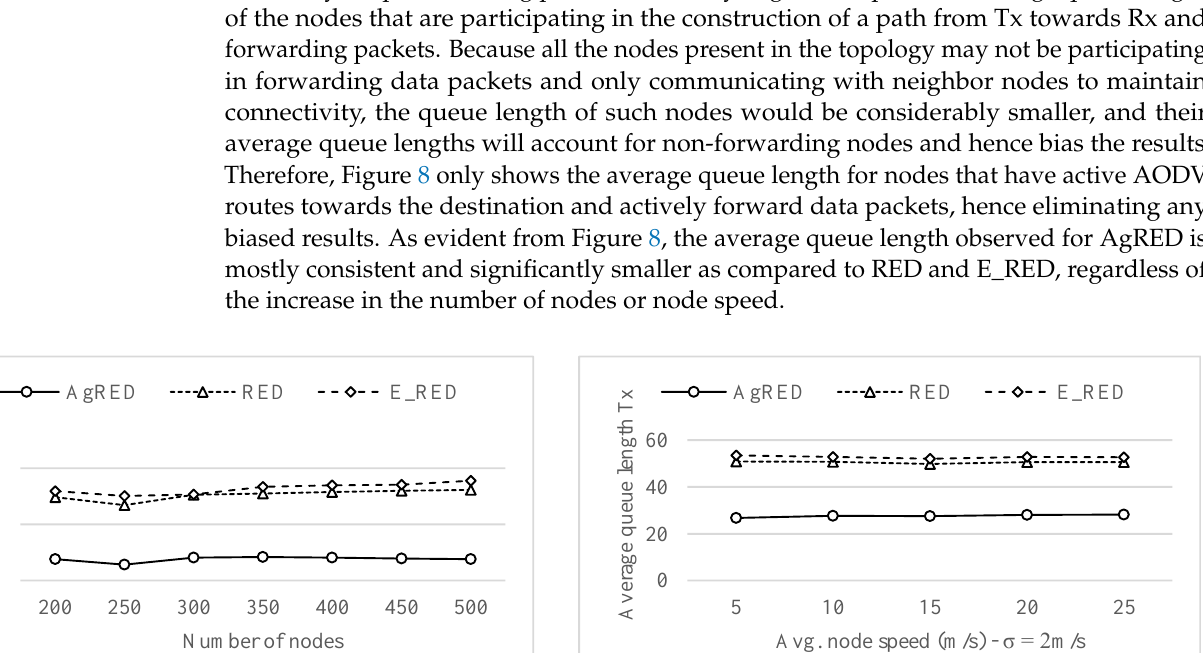
Figure 7. Average queue length of transmitter vs. ( a ) number of nodes and ( b ) average node speed.